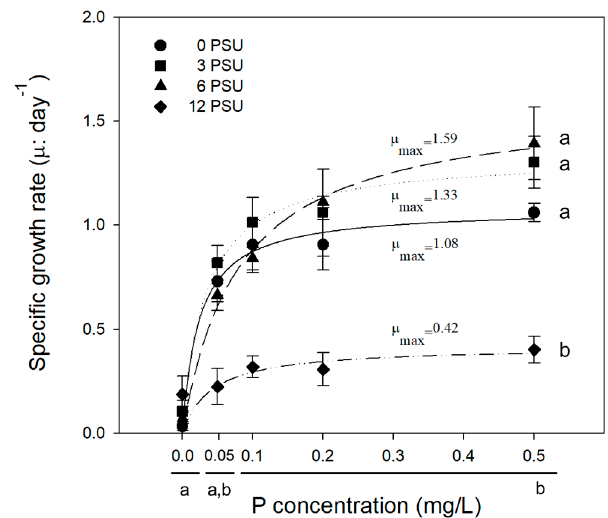
Figure 1. Variation in specific growth rate ( µ ) of Scenedesmus quadricauda with increasing P concentration at salinity levels of 0, 3, 6, and 12 psu. Experimental conditions are presented in Table 1 (Exp. 1). Data are presented as averages with standard deviations (bars). Lower case letters on the right side and bottom indicate significant di ff erences ( p <